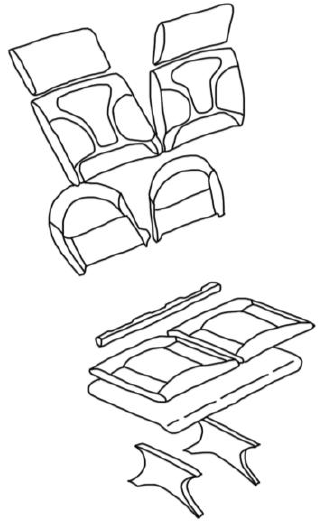
Figure 30. US Patent 007,954,762 B2 light yet strong material